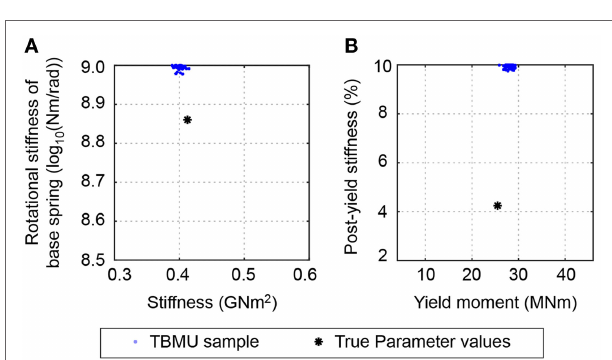
distribution depends on the parameters that are chose for the